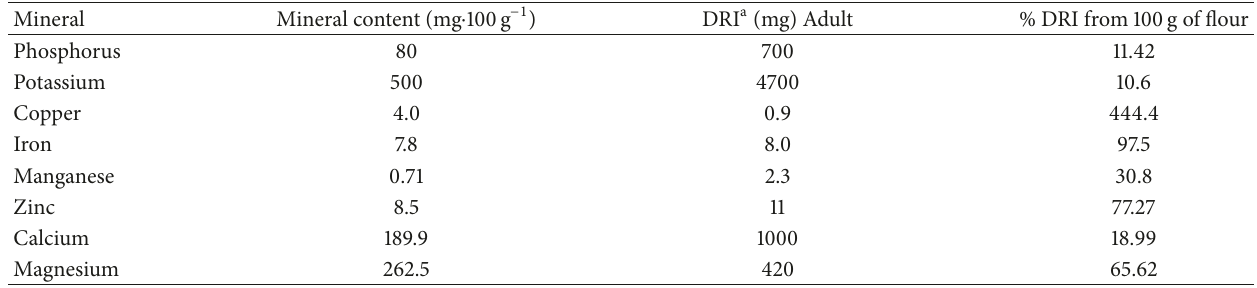
Table 3: Mineral composition of CBA